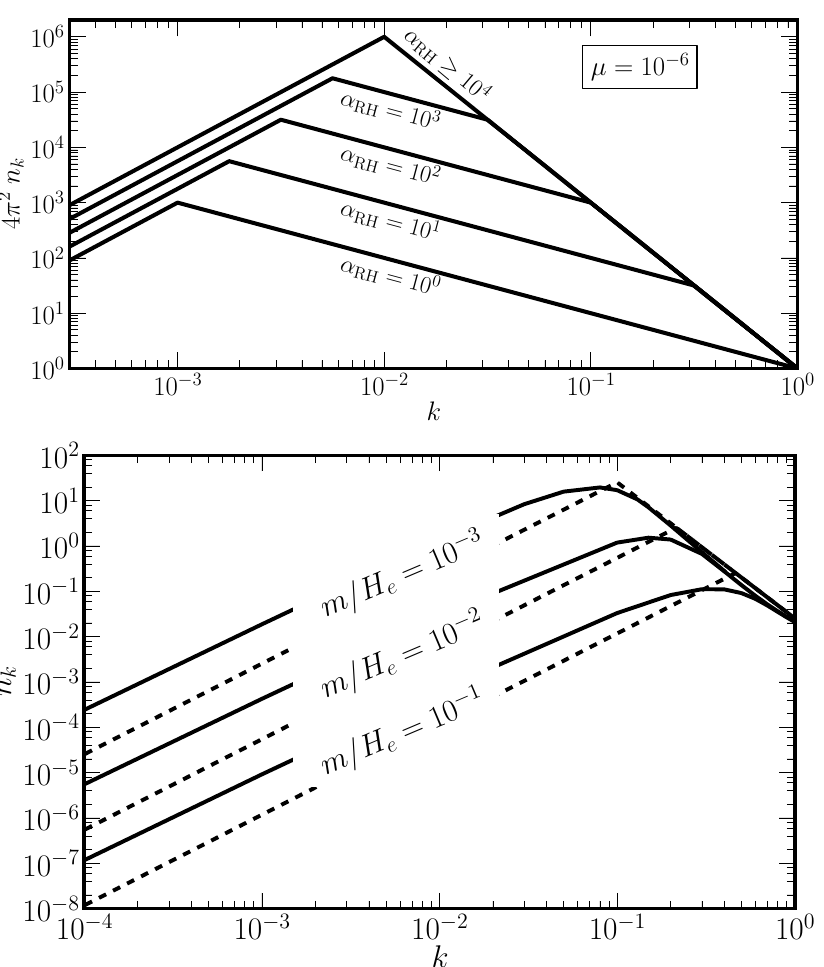
Figure 6 . Top panel: the final spectrum as a function of k for late reheating ( α RH µ 2 / 3 > 1 ; for µ = 10 − 6 this implies α RH ≥ 10 4 ) using eq. (5.27), for early reheating ( 1 > α RH µ 2 / 3 > µ 2 / 3 ) using eq. (5.35), and for immediate reheating ( α RH = 1 ) using eq. (5.37). Bottom panel: the final value of n k for m/H e = 10 − 3 , 10 − 2 , and 10 − 1 assuming α RH µ 2 / 3 > 1 . The solid curves are numerical results for the chaotic model while the dashed curves are the analytic approximation of eq. (5.26). At low k they differ by a factor of ∼ 10 , which is explained in the